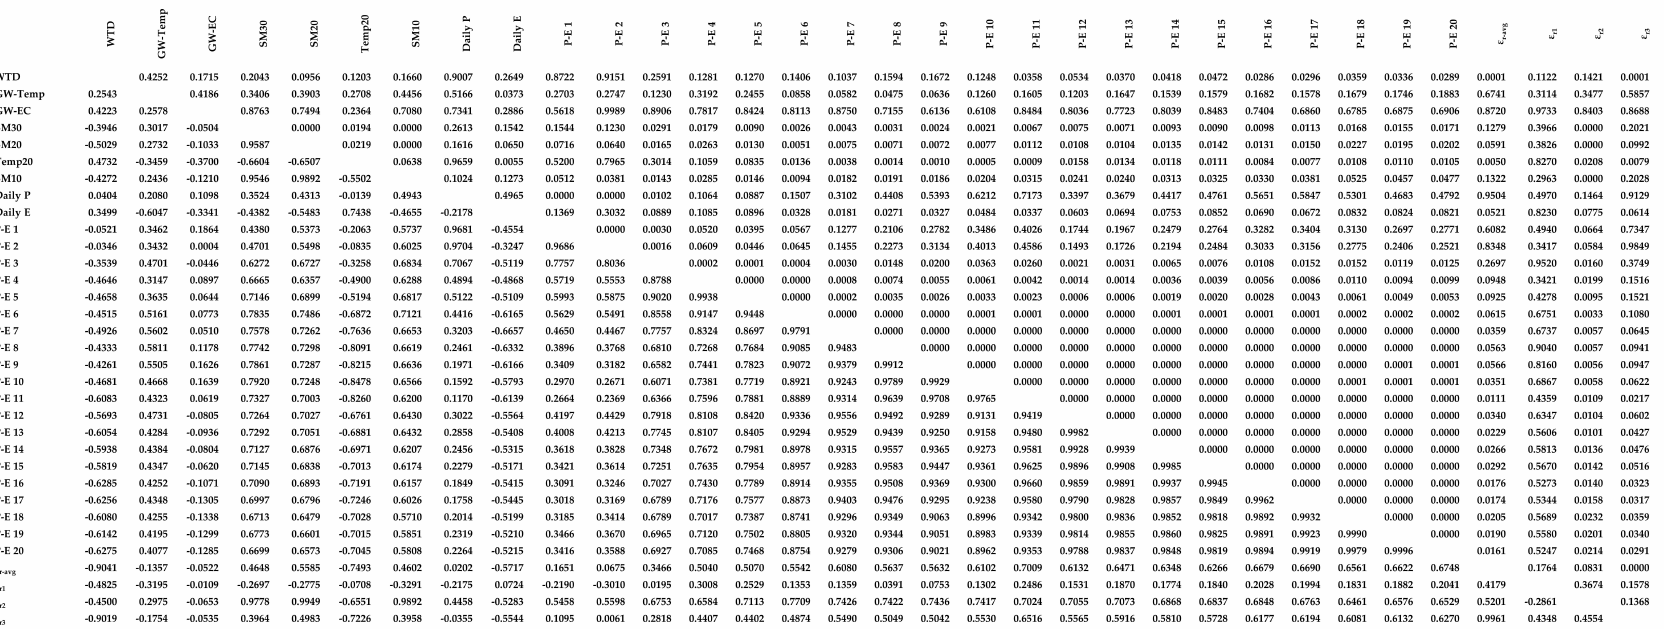
Figure A3. Results of Pearson’s correlation analysis. The correlation coe ffi cients ( r ) are shown in the lower triangle, and the corresponding p -values are shown in the upper